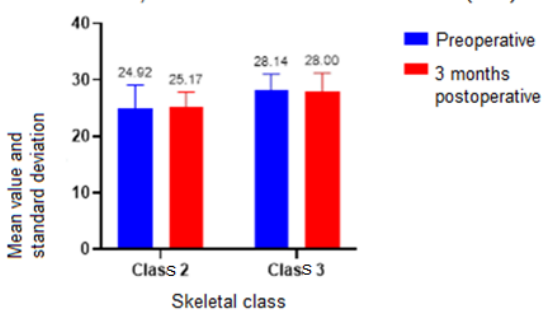
Figure 9. Nose width assessment, insertions of the nasal fins.